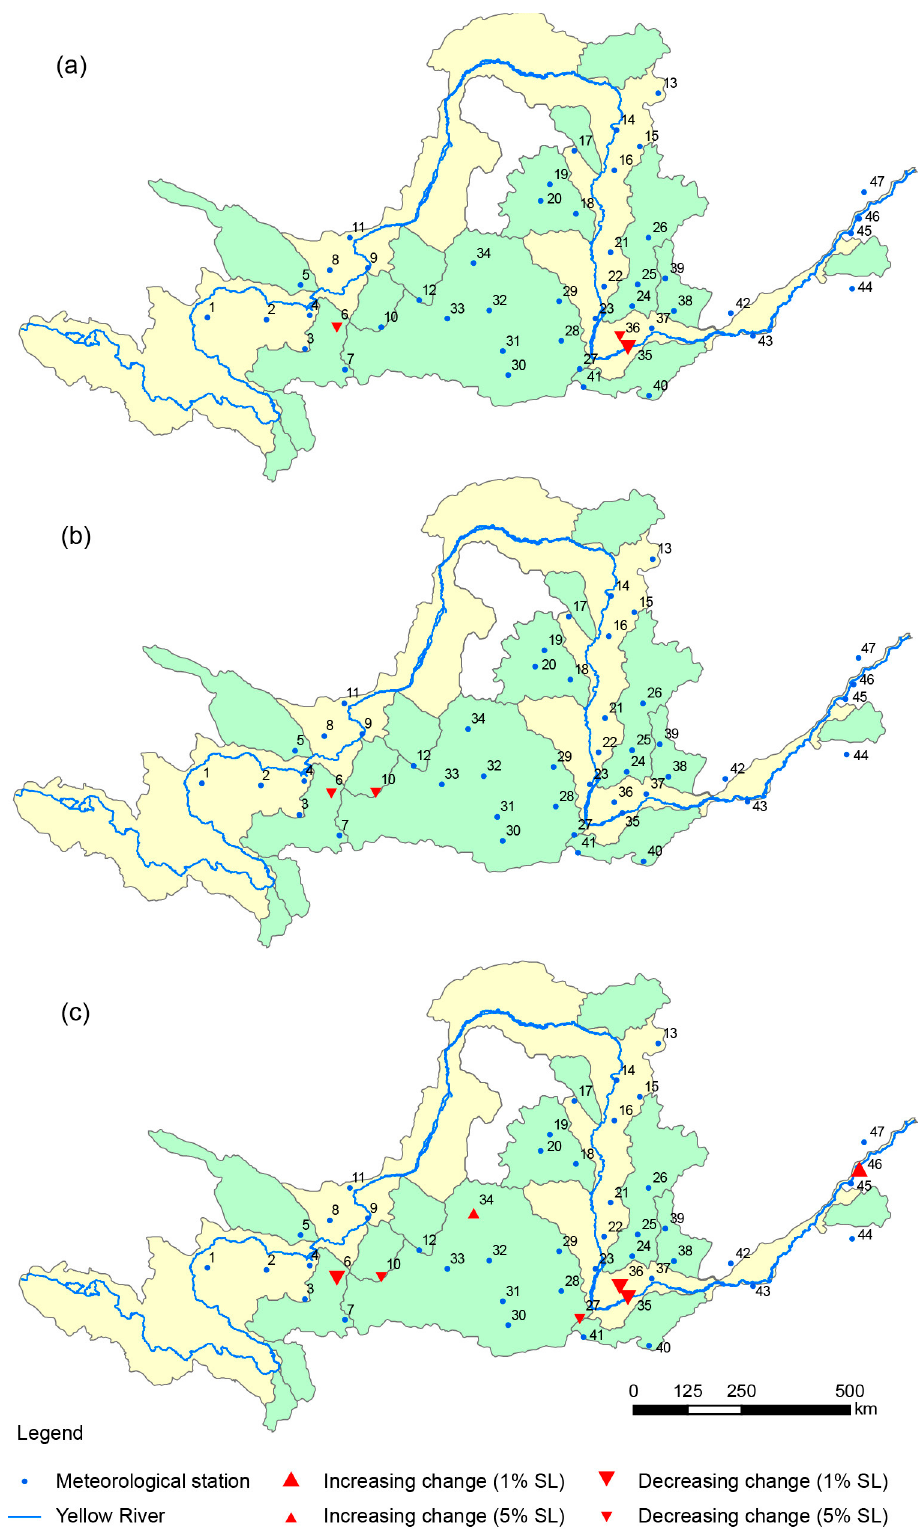
Figure 6. Significant changes in ( a ) annual maximum consecutive 1-day rainfall (RX1day); ( b ) annual maximum consecutive 5-day rainfall (RX5day) and ( c ) extreme daily rainfall that is larger than the 99th percentile (R99) in the Yellow River Basin detected by the PTM index. The abbreviation SL stands for signi fi cance level. Sometimes the RX1day and RX5day were outliers, which may not reflect a universal change of extreme rainfall. Thus, more extremes should be extracted from daily rainfall. The 99th percentile